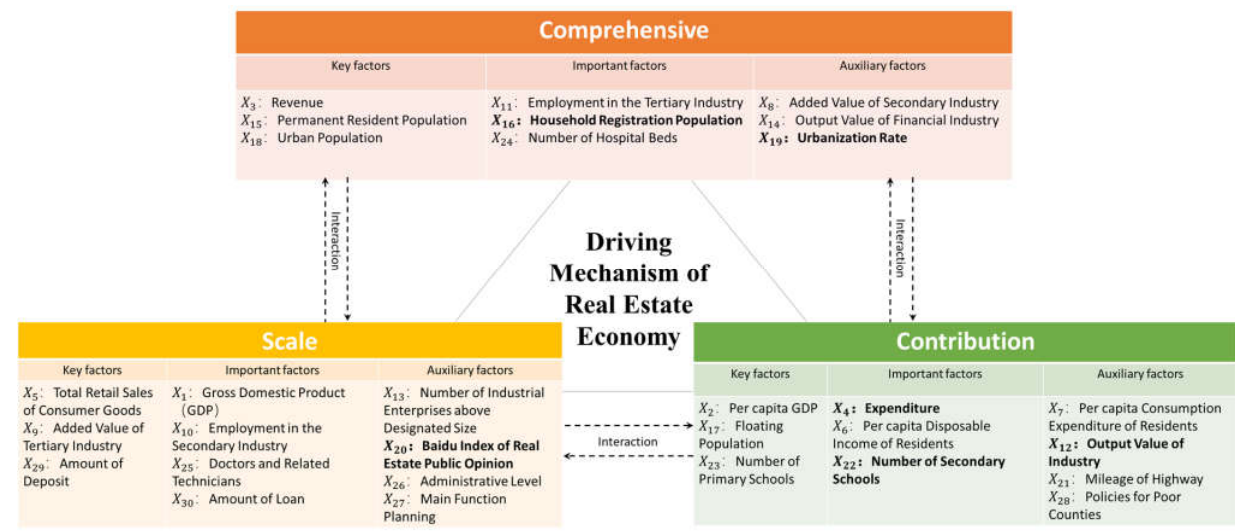
Figure 11. Driving mechanism of real estate economy.